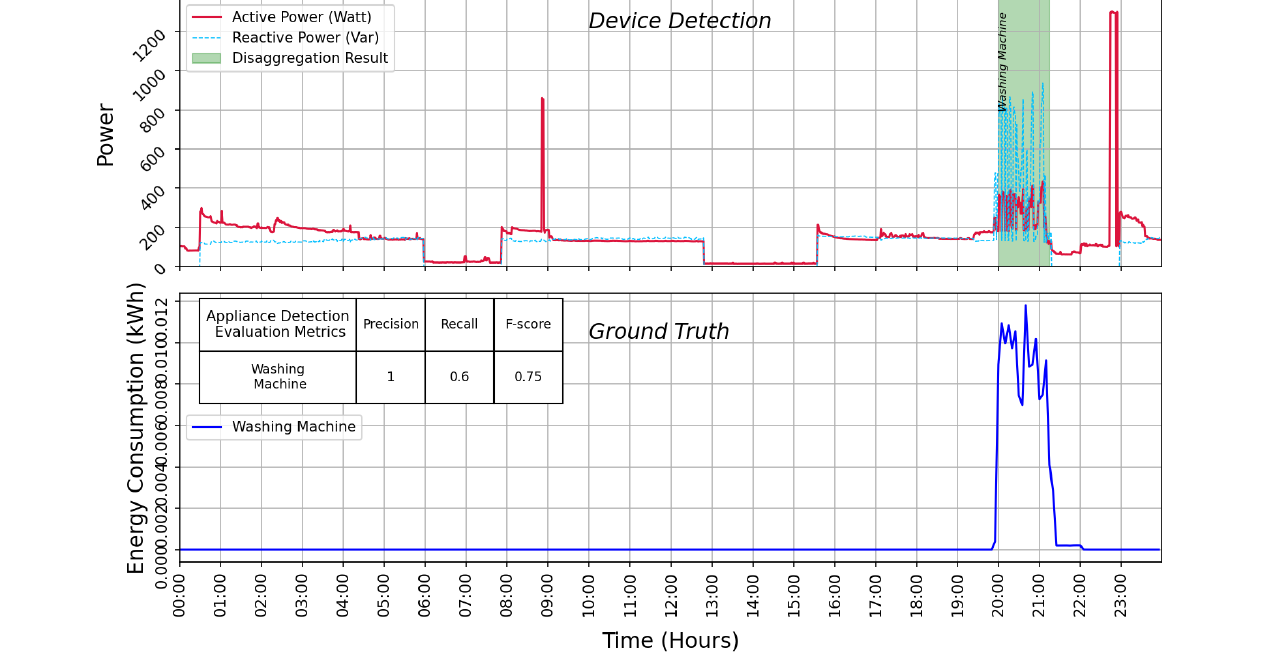
Figure 11. UP-dd results for washing machine detection and comparison with ground truth deriving from a smart